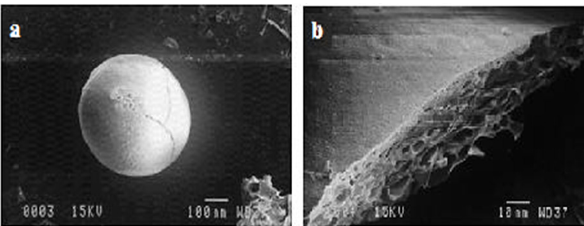
Fig. 3 . SEM images of γ-alumina nanosphere prepared in acidic medium , a) after calcination at 650 o C for 3 hours; b) porous powder image after breaking of nanosphere 5a). The Al-A sample has a hysterics loop of type 2 (H2) that suggests a broad pore size distribution (Fig. 5b).